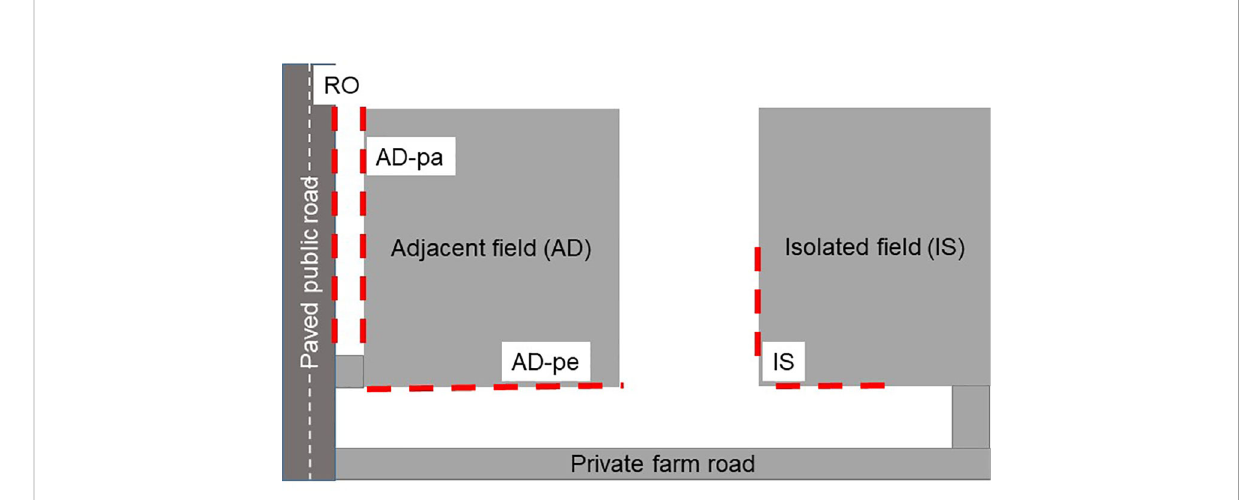
FIGURE 2 Schematic representation of fi eld pairs (adjacent fi eld and isolated fi eld) and sampling transects (red dashed lines).